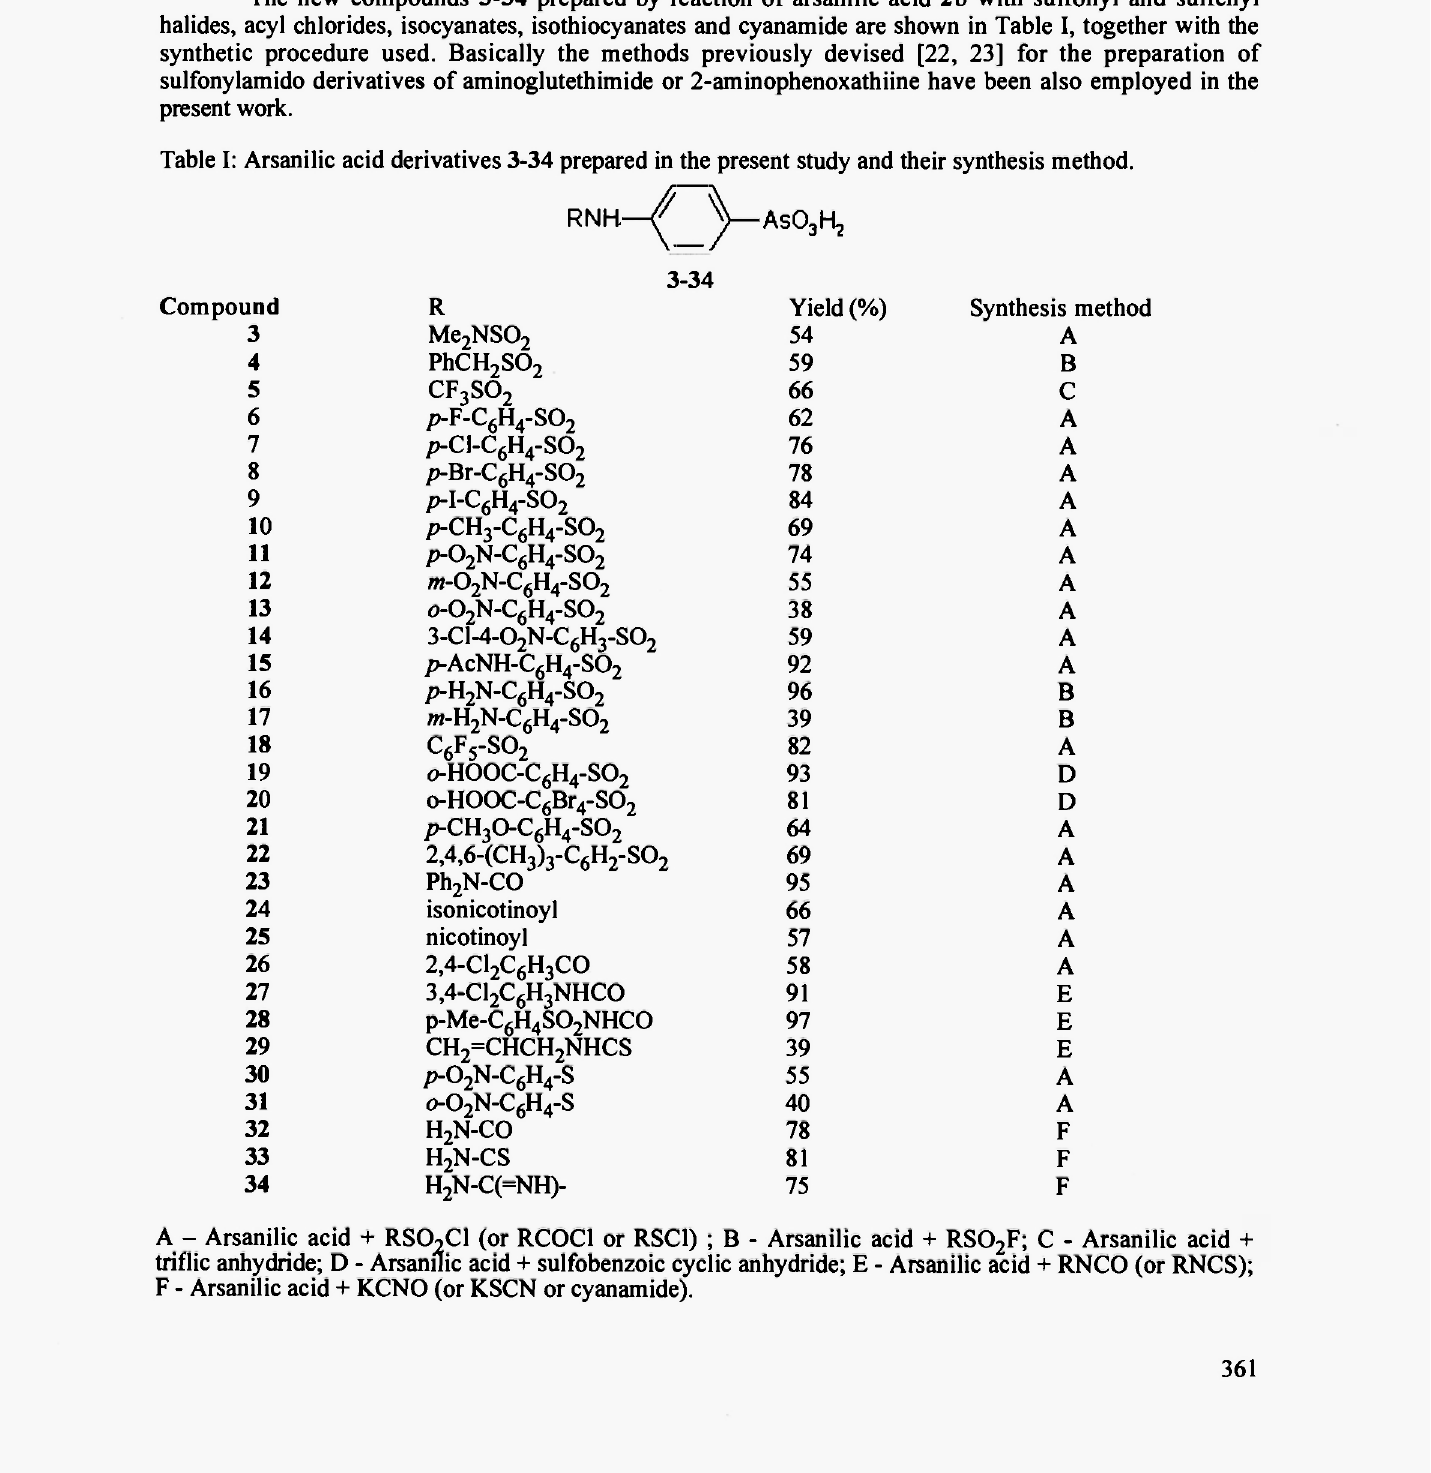
Table I: Arsanilic acid derivatives 3-34 prepared in the present study and their synthesis